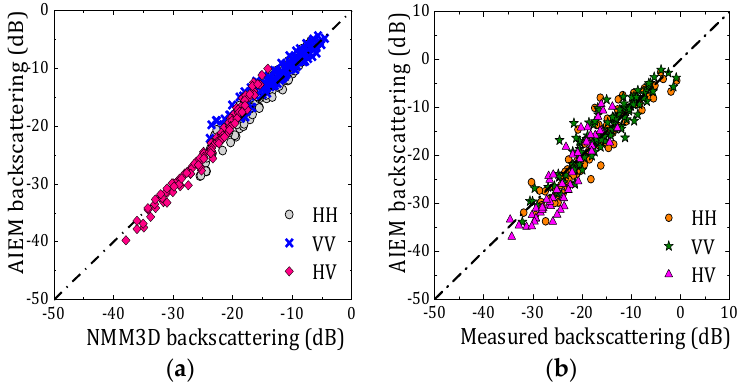
Figure 2. Correlation plot for co- (HH & VV) and cross-polarized (HV) backscattering coefficients ( a ) between AIEM prediction and full-wave numerical simulations (NMM3D) and ( b ) between AIEM prediction and experimental measurements (POLARSCAT data).